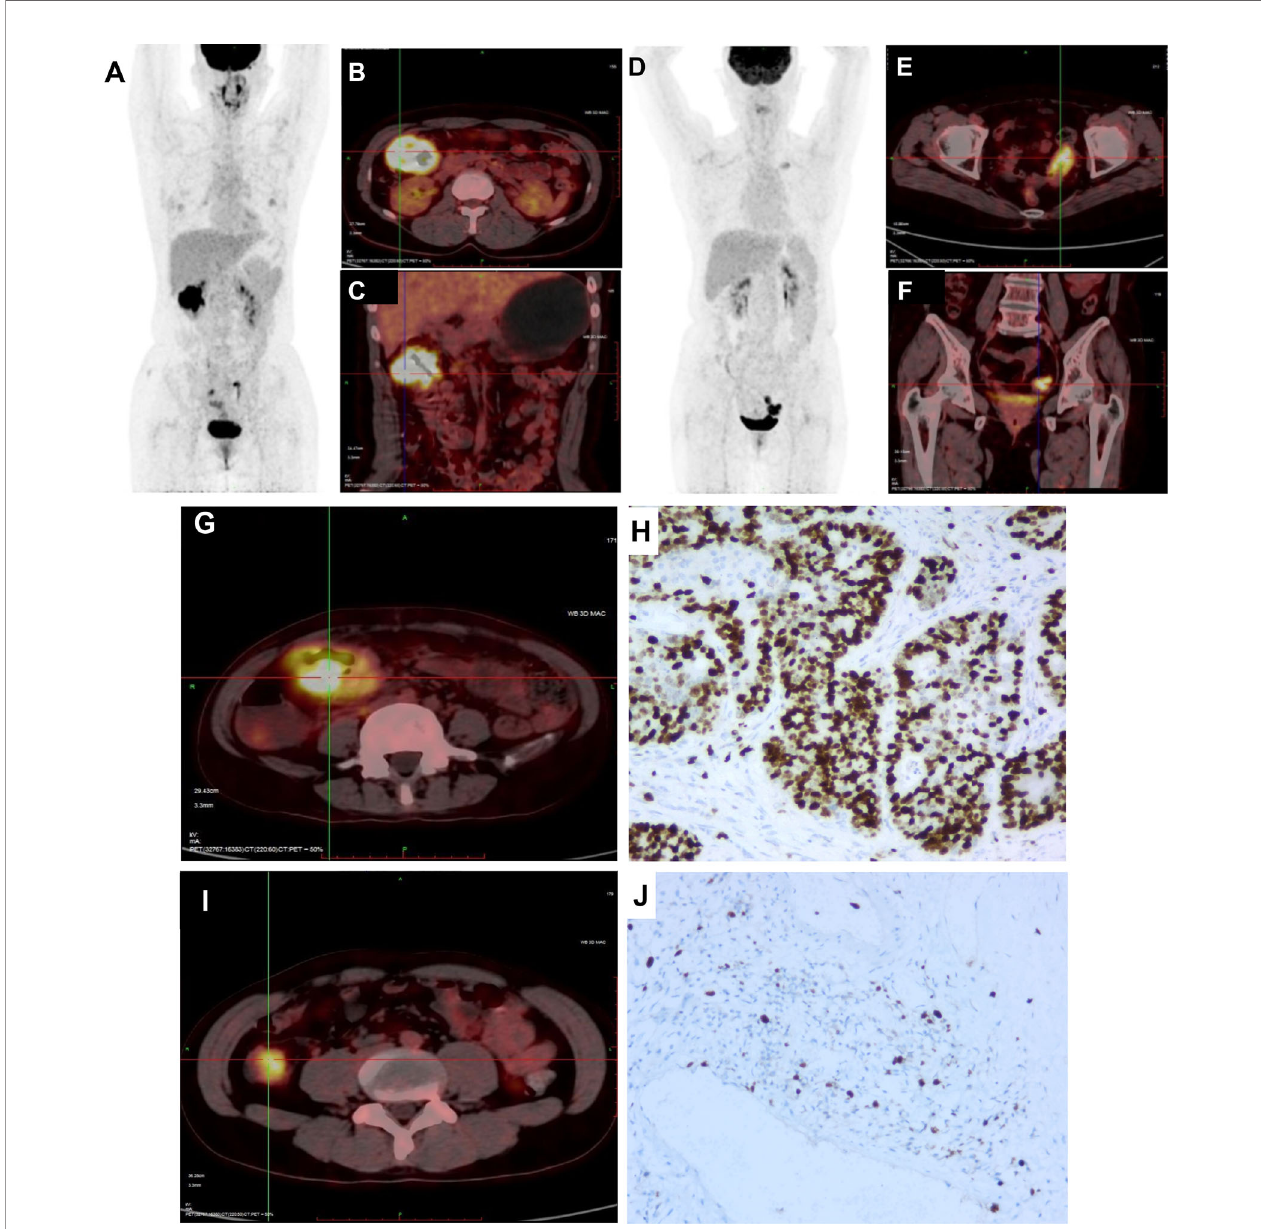
FIGURE 3 | Representative images of KRAS mutation of 18 FDG-PET/CT scan and Ki-67 index in CRC patients. (A) 18FDG-PET/CT scans image of CRC patient with mutated-type KRAS. (B, C) 18FDG-PET/CT scans showed intense accumulation of 18FDG in the hepatic fl exure of colon (SUV: 20.0). (D) 18FDG-PET/CT scans image of CRC patient with wild-type KRAS. (E, F) 18FDG-PET/CT scans showed intense accumulation of 18FDG in the sigmoid colon (SUV: 12.4). (G) 18FDG was accumulated in the sigmoid colon (SUV: 21.3). (H) Maximum IHC expressions are 77.8% for Ki-67. (I) 18FDG was accumulated in the sigmoid colon (SUV: 12.4). (J) Maximum IHC expressions are 22.7% for